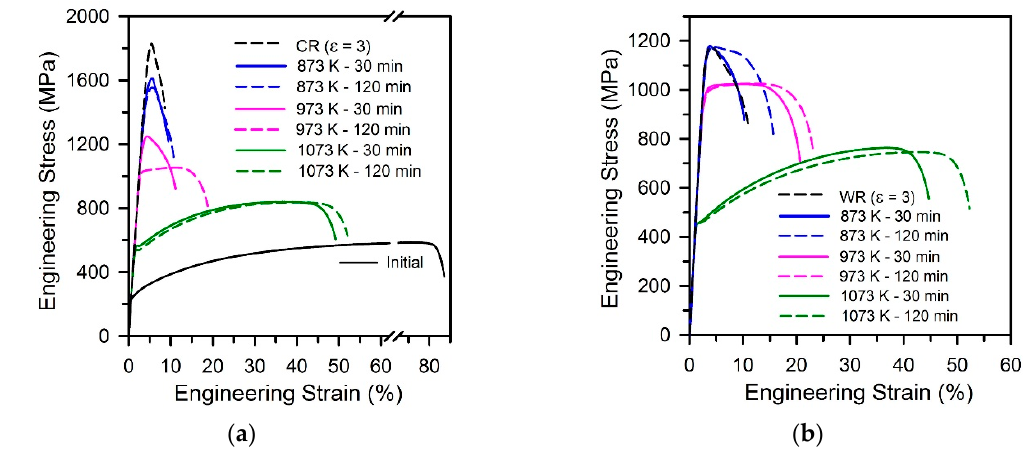
Figure 6. Engineering stress-strain curves for a 316L-type stainless steel processed by cold ( a ) or warm ( b ) rolling and then annealed under the indicated conditions.